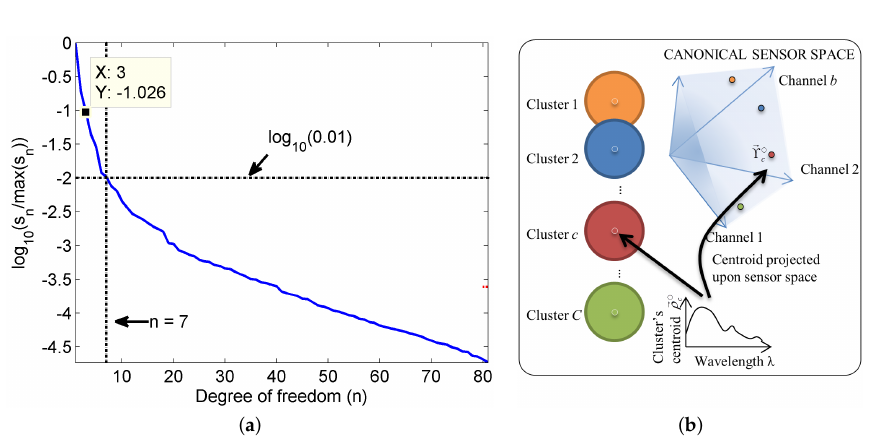
Figure 7. Estimating a suitable value for the number of clusters can be done by analyzing the singular values of the reflectance data ( a ); illustration of the formation of the lookup table in given in ( b ). It is seen that n = 8 corresponds to a very small ratio of σ n /max ( σ n ) (<1%). This indicates